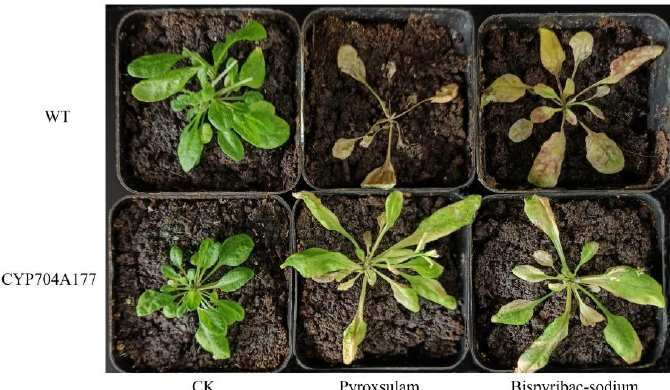
Figure 6. Growth response of Arabidopsis transformed with CYP704A177 to pyroxsulam (2.81 g a.i./ha) and bispyribac-sodium (7.5 g a.i./ha) .